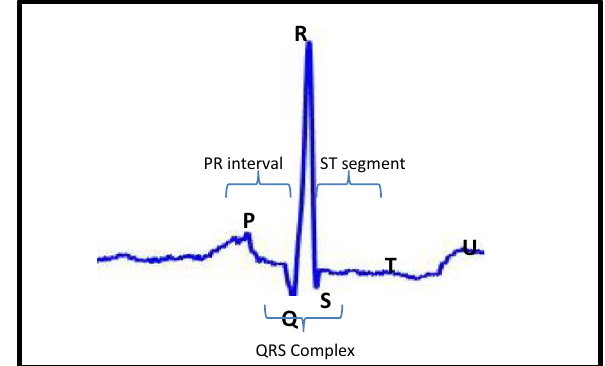
Fig. 1 Normal class of ECG